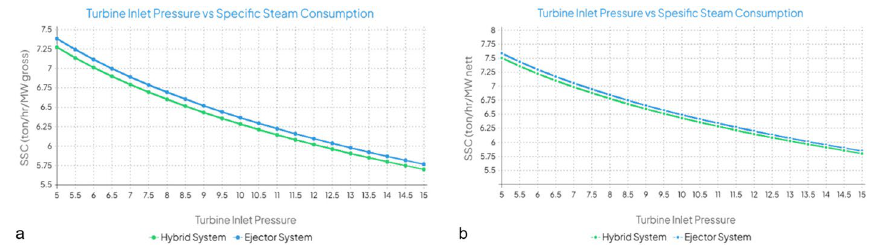
Fig. 19 Graphs of the effect of turbine inlet pressure on SSC of each type of GRS a SSC gross b SSC nett